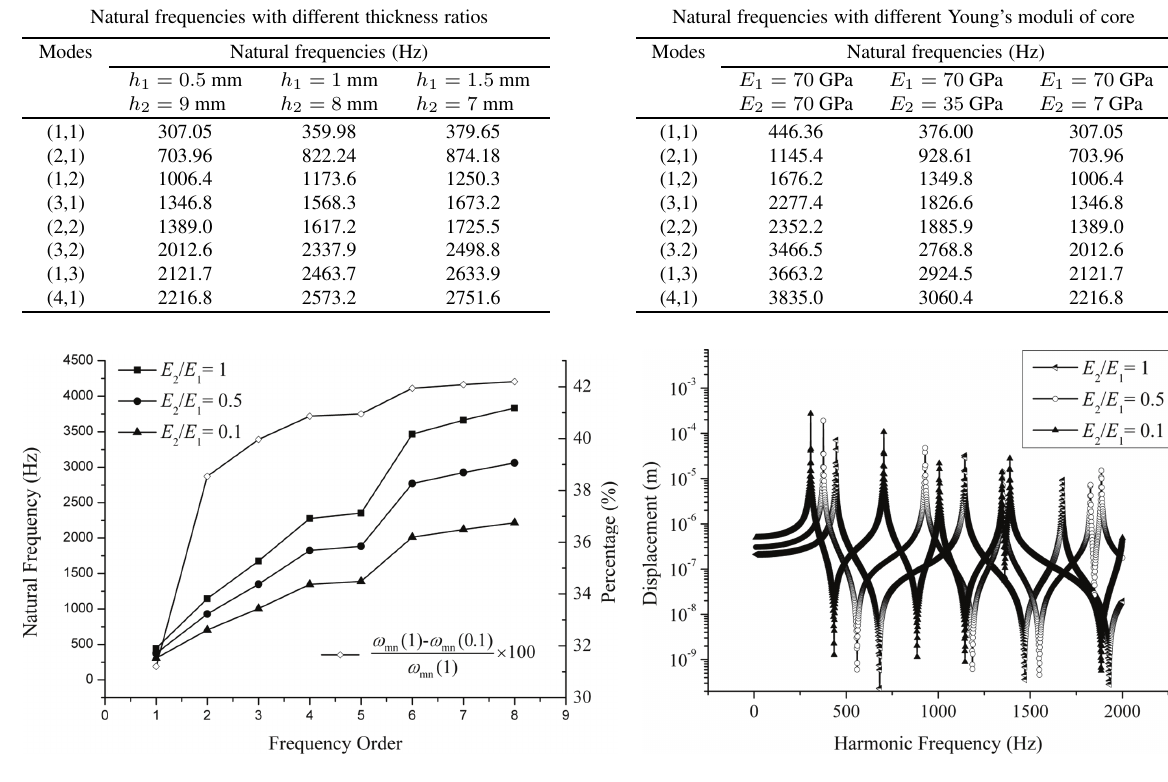
Fig. 21. Natural frequencies and their relative difference. Fig. 22.